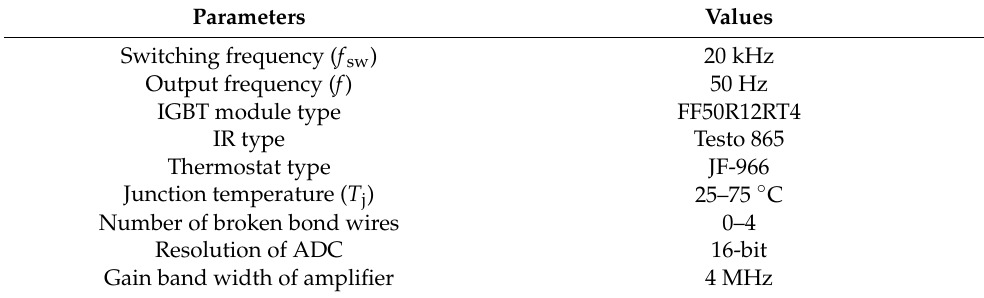
Table 2. Experimental platform parameter